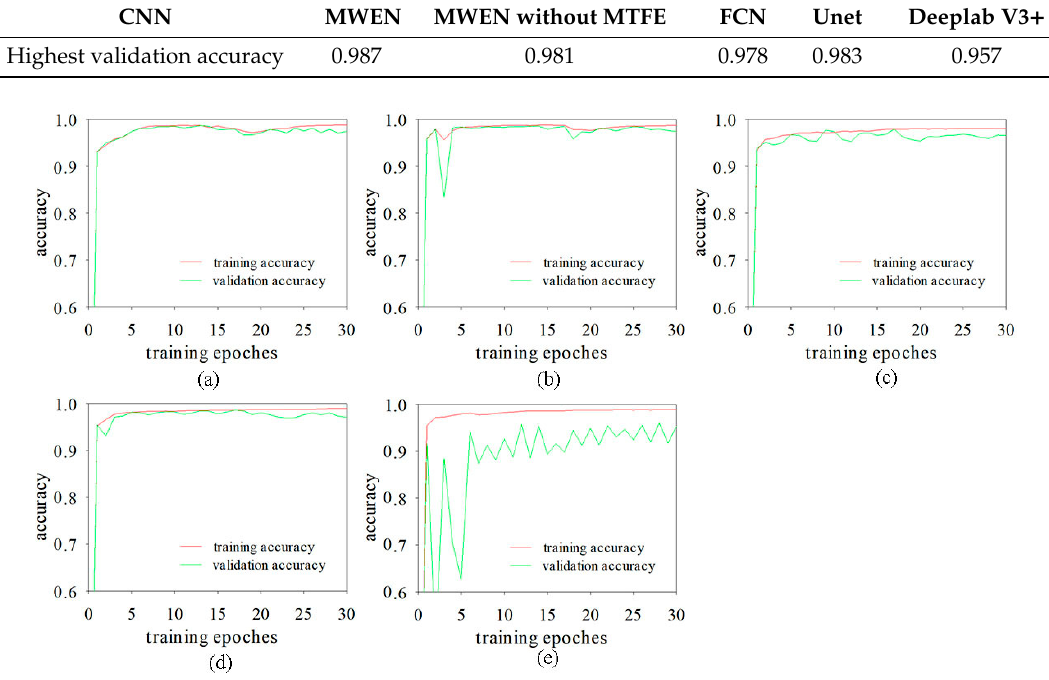
Table 3. The highest validation accuracy of CNN models in training process.